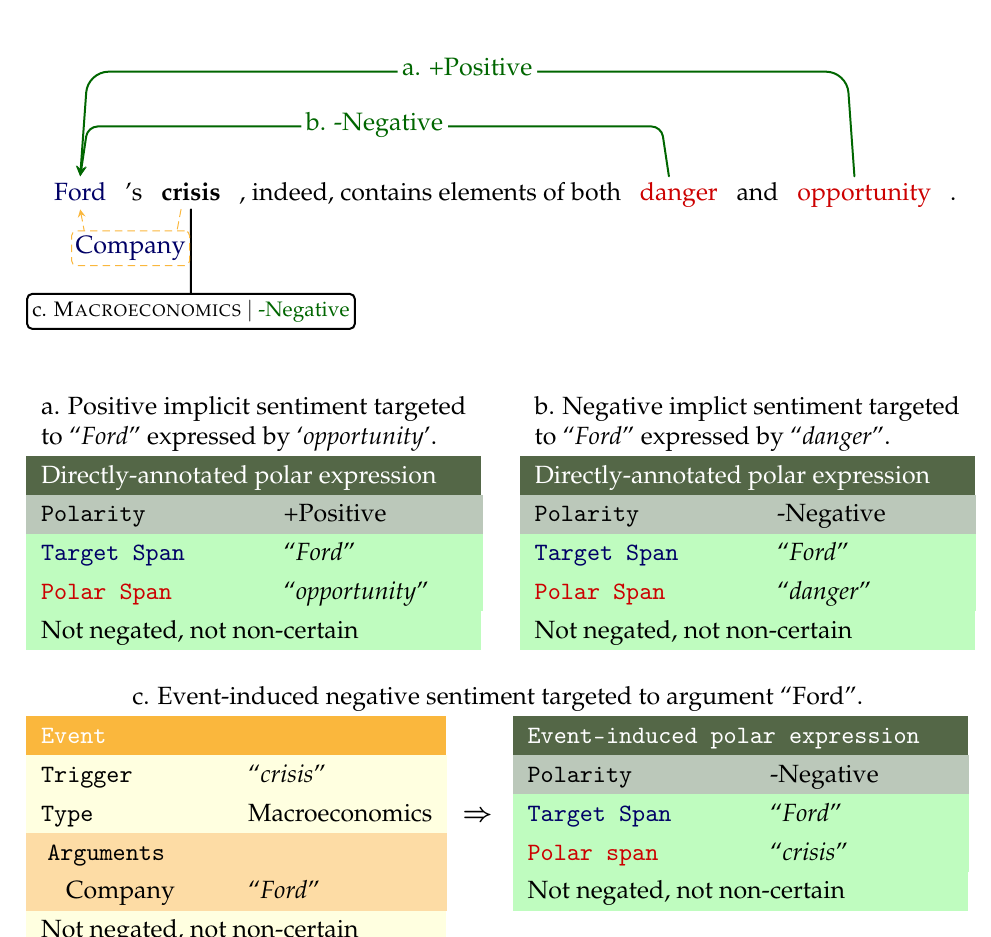
Figure 2. Examples of two directly annotated implicit target sentiment expression annotations ( a , b ) and one event-induced sentiment ( c